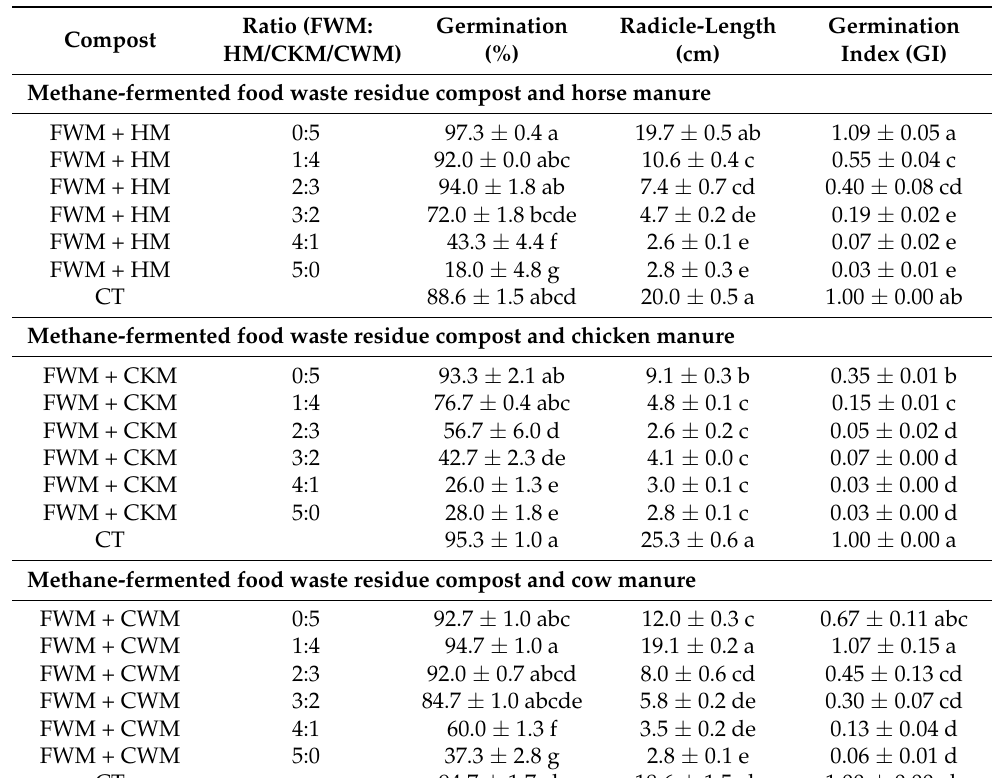
Table 2. Germination, radicle-length, and germination index of komatsuna affected by different compost ratios. Ratio (FWM: Compost